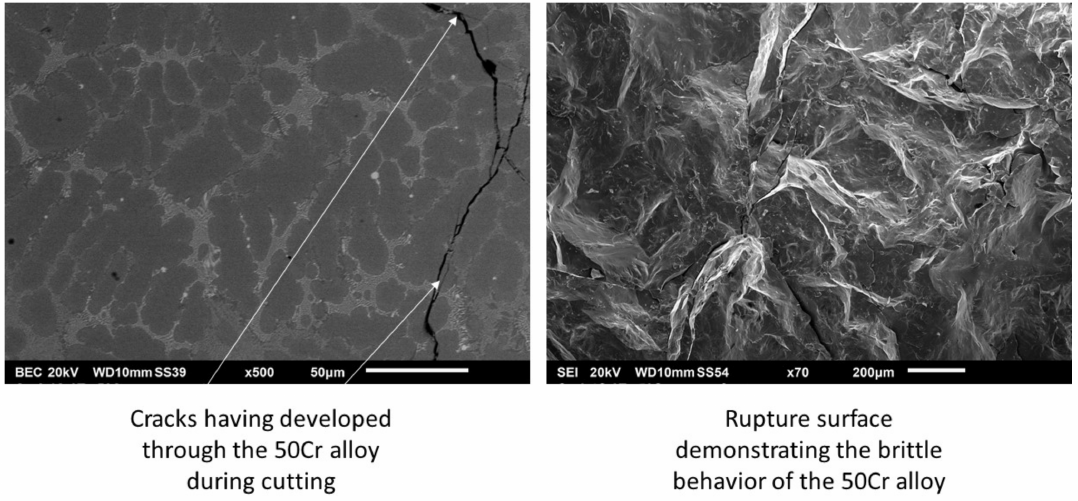
Figure 14. Crack propagation in the 50Cr alloy during cutting and fractographic view of a broken